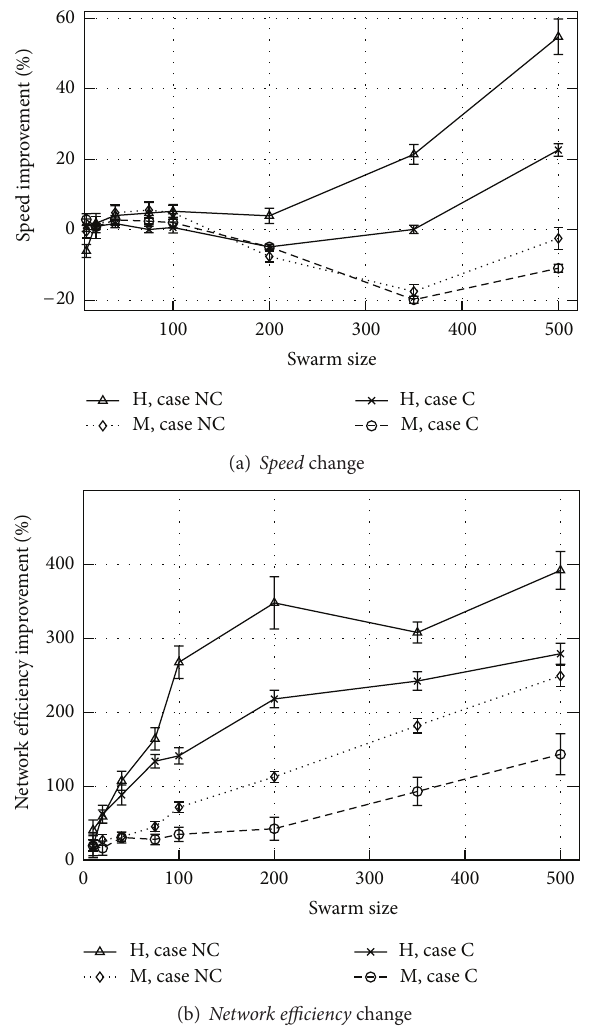
Figure 12: Scenario II: improvement against the reference R tree creation